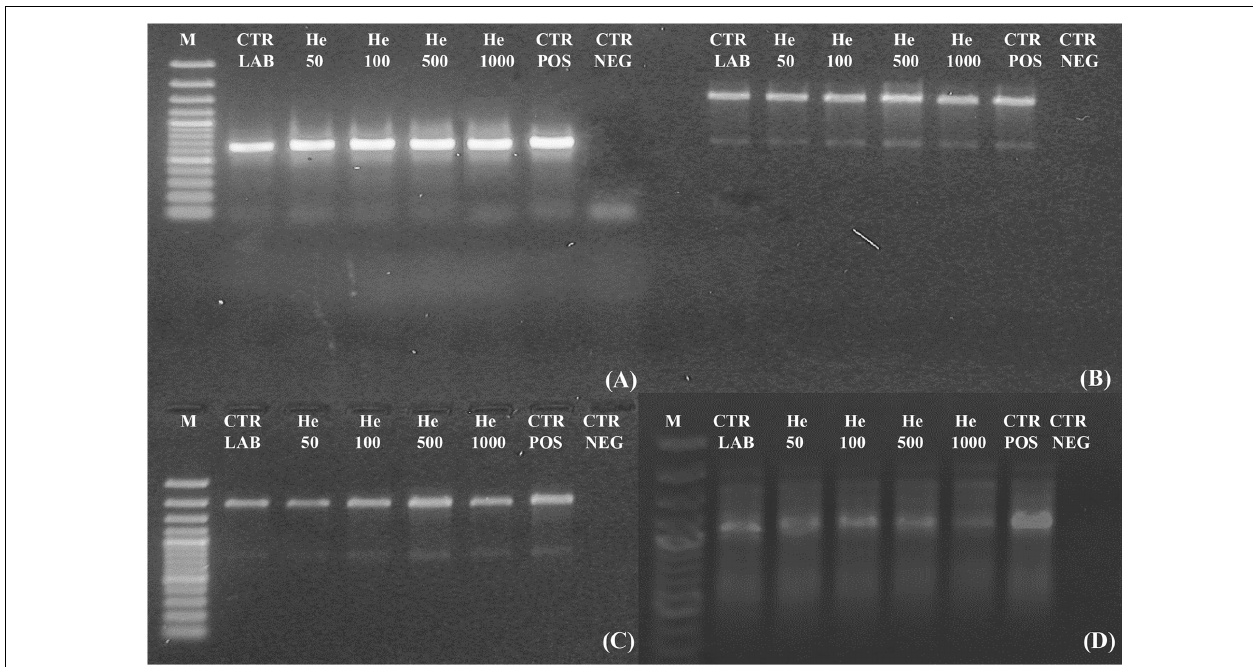
FIGURE 4 | Assessment of the DNA integrity on C. antarcticus single gene PCR (A) 700 bp; (B) 1,600 bp; (C) 2,000 bp and (D) genomic DNA damage as revealed by RAPD assay. M : DNA ladder, POS CTR : fresh colonies, NEG CTR : PCR negative